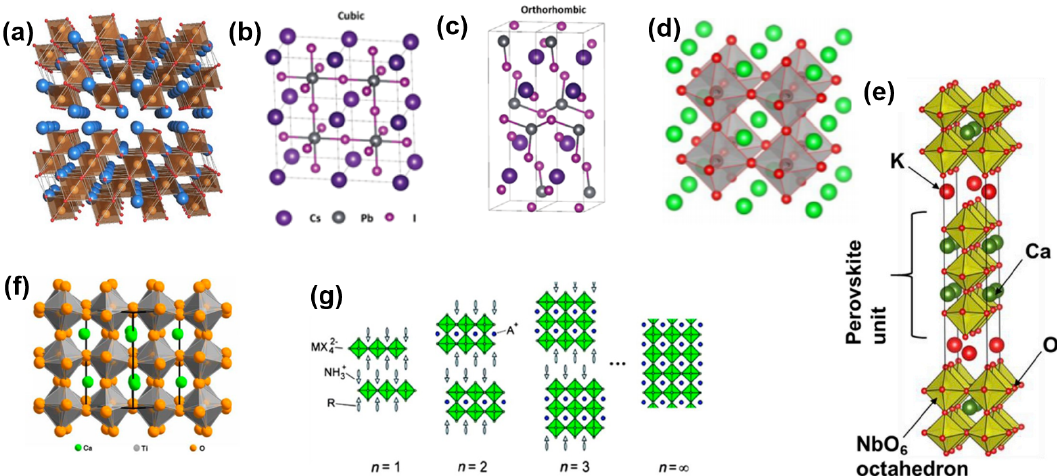
Figure 21. ( a ) Crystal structure of Ba 5 Nb 4 O 15 , reproduced with permission from reference